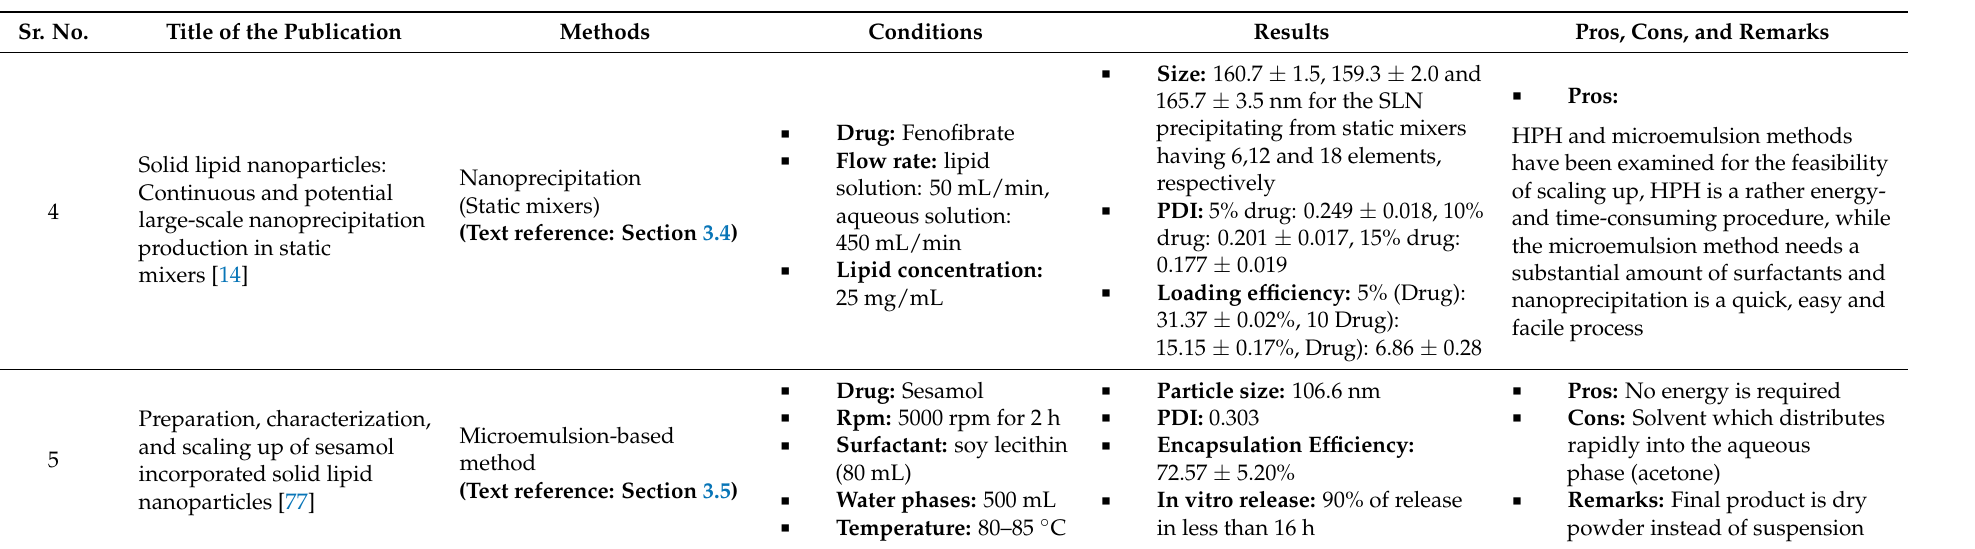
Table 1. Summary of the scale-up methods of solid lipid nanoparticles.